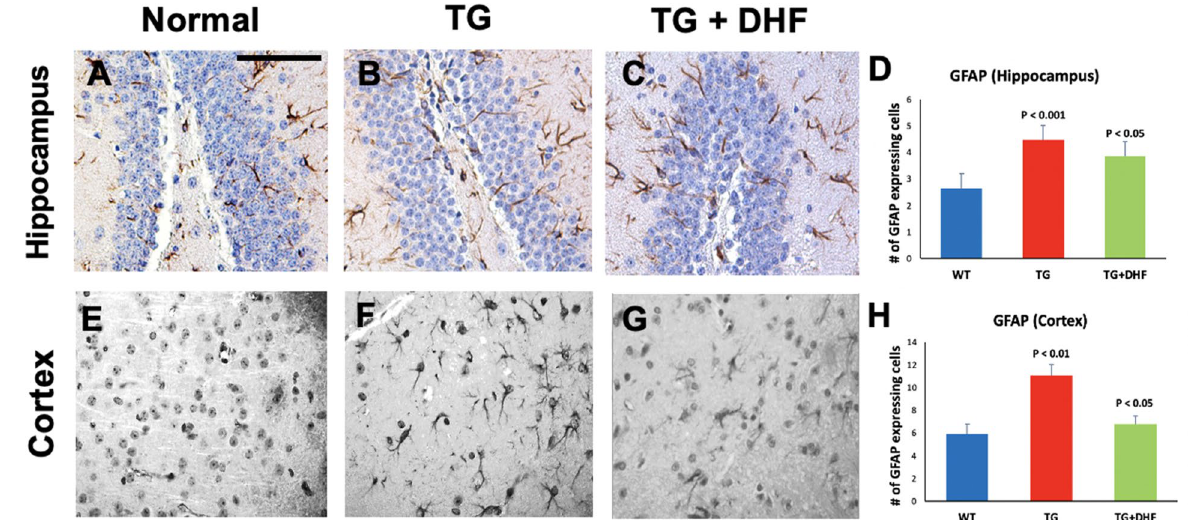
Figure 4. DHF treatment reduced astrogliosis in the brain of Tg26 mice: Legend: GFAP expression in the hippocampus and cortex of Wild Type (WT), Tg26, and DHF treated Tg26 mice ( A - H ). Immunohistochemical stained sections show GFAP expressing cells in the hippocampal and cortex regions of the mice brains. 3 WT mice, 3 Tg26 mice, and 4 TG + DHF mice were used. A, B, C and E,F,G are 400 × magnification pictures of the hippocampus and cortex regions, respectively, of the mice. ( D ) Quantification of GFAP expressing cells in the hippocampus: p < 0.001, WT versus Tg; p < 0.05 Tg versus Tg + DHF. ( H ) Quantification of GFAP expressing cells in cortex: p < 0.01, WT versus Tg; p < 0.05, Tg versus Tg + DHF. The total numbers of hippocampal fields analyzed (WT, Tg26, TG + DHF) were (61, 74, 107). The total numbers of cortex fields analyzed (WT, Tg26, TG + DHF) were (15, 15, 20). One Way ANOVA with Bonferroni’s Multiple Comparison post-test. scale bar, 100